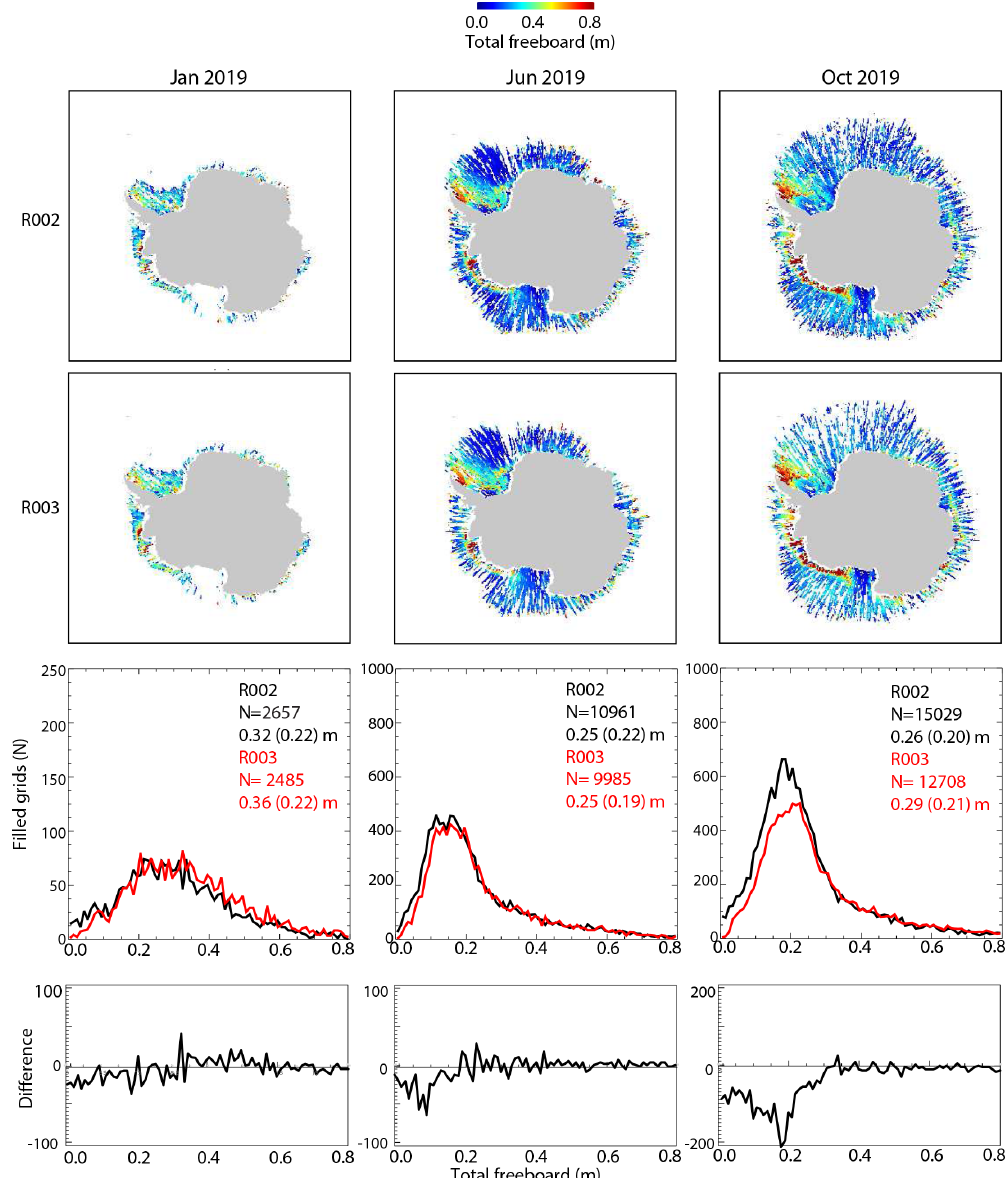
Figure 6. As in Fig. 5 but for the